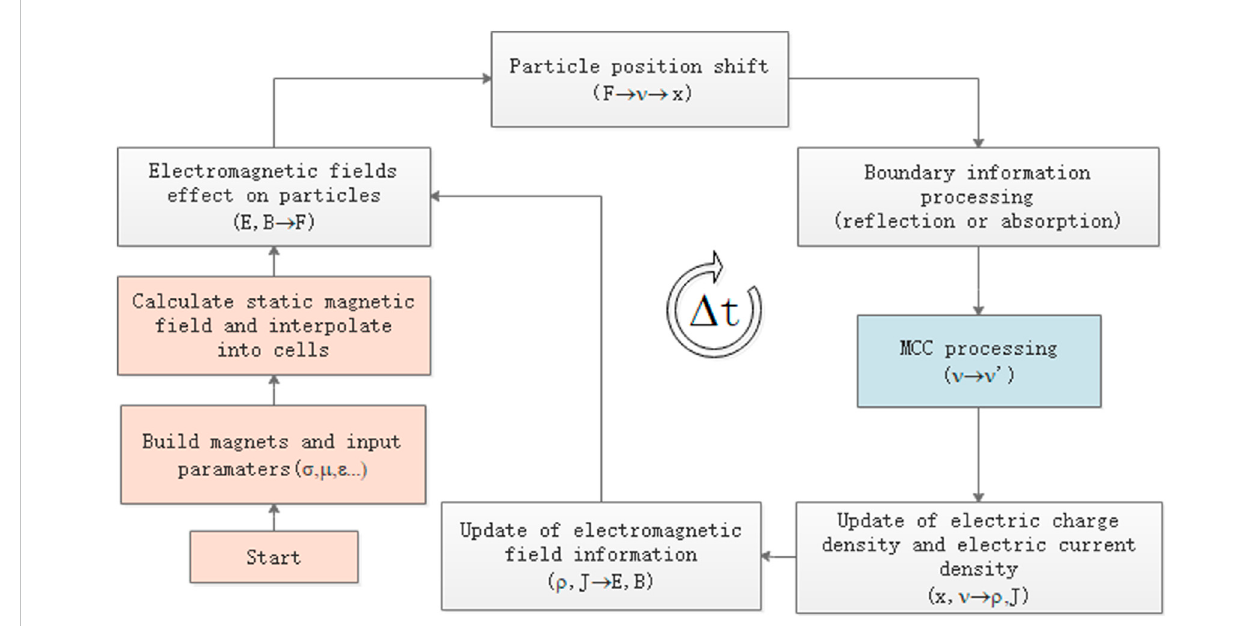
FIGURE 1 The process cycle diagram of PIC/MCC and SMPM methods on CHIPIC